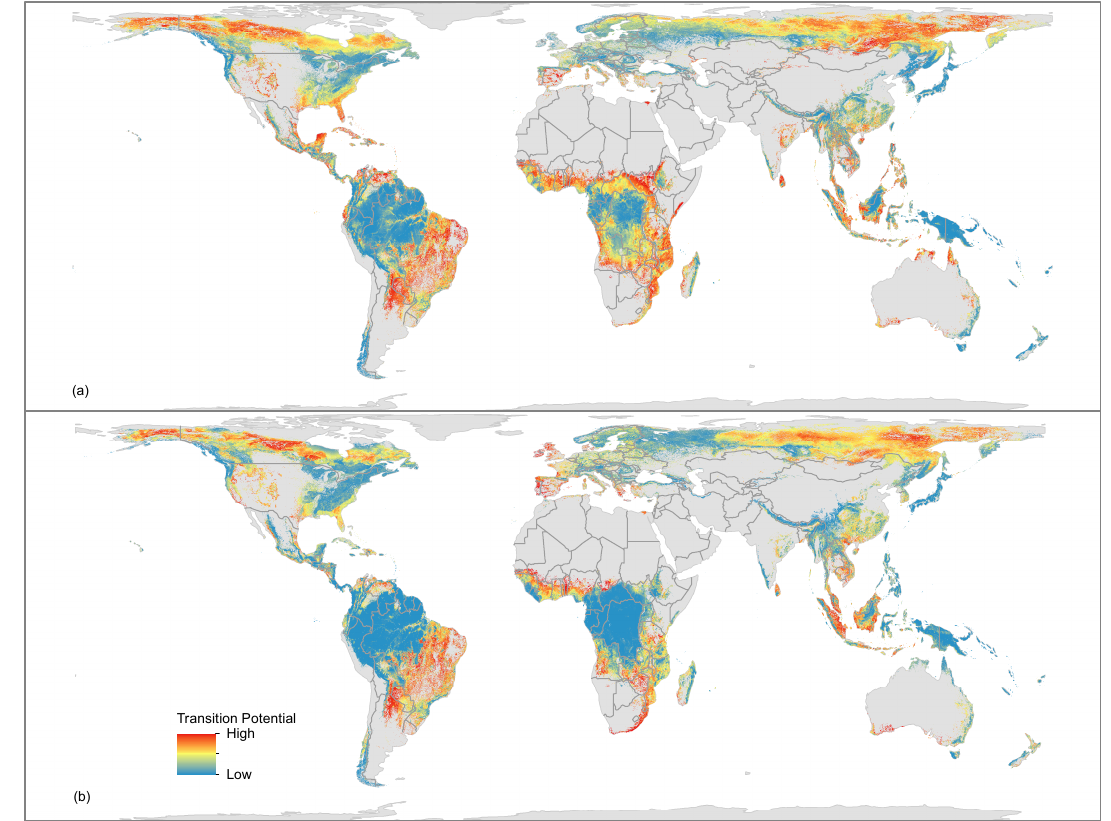
Figure 2. Results for the Global model ( a ) and Regional models ( b ) (displayed together) showing areas of high potential to transition from tree cover to tree cover loss (red) to areas of low potential to transition